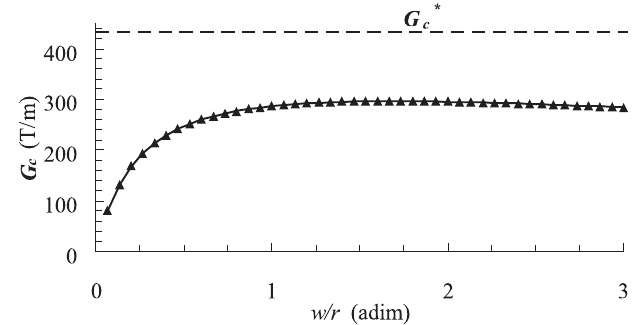
12. (Color) Numerical evaluation of the critical gradient versus conductor surface for different sector